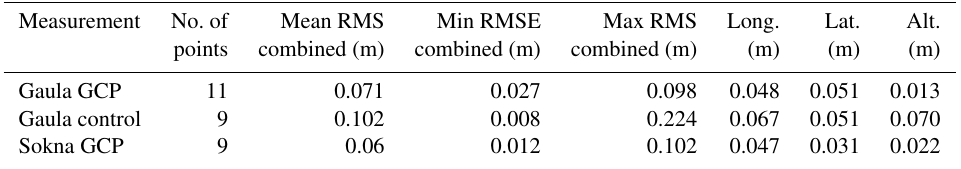
Table 1. Root mean square error computed from GCP and control points. The error is reported for the combination of x , y , z and error for each